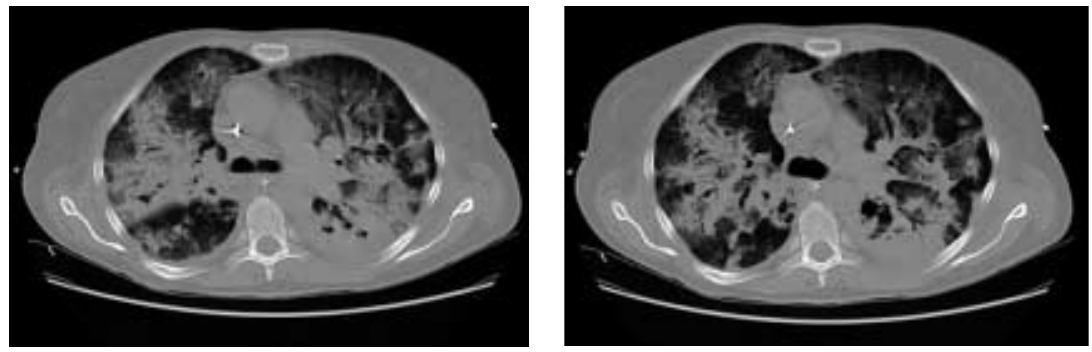
Figure 3 An example of an ARDS patient with low potential for